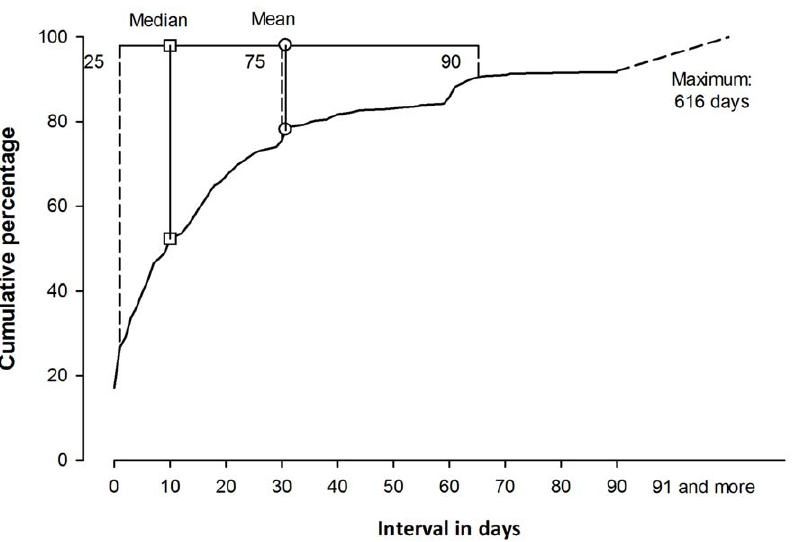
Figure 1. Cumulative interval in days between self-reported symptom onset and attending first health care facility, of new PTB cases among the migrant population recruited in Shanghai, Guangdong, and Jiangsu, China, 2008. The thin horizontal line denotes the range from the 25 th to the 90 th percentile with the square symbol denoting the median and the circle the mean. Dashed vertical lines are the 25 th , 75 th , and 90 th percentiles, and the two thin vertical lines the median and mean respectively.